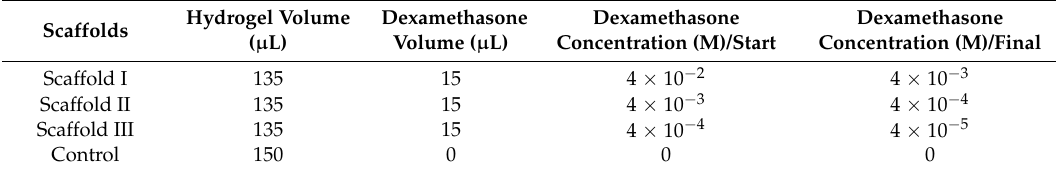
Table 1. Dexamethasone (DEX)-loaded [COCH 3 ]-RADARADARADARADA-[CONH 2 ] (RADA 16-I) scaffold with three different concentrations of